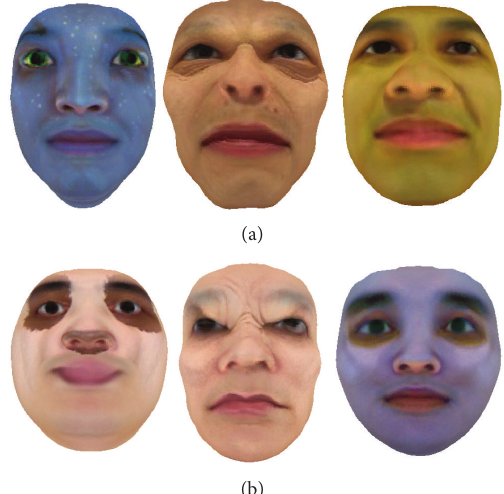
Figure 12: Linear interpolation results. (a) The results from the first row of Figure 9 but using linear interpolation technique. (b) The results from the first row of Figure 10 but using linear interpolation technique.